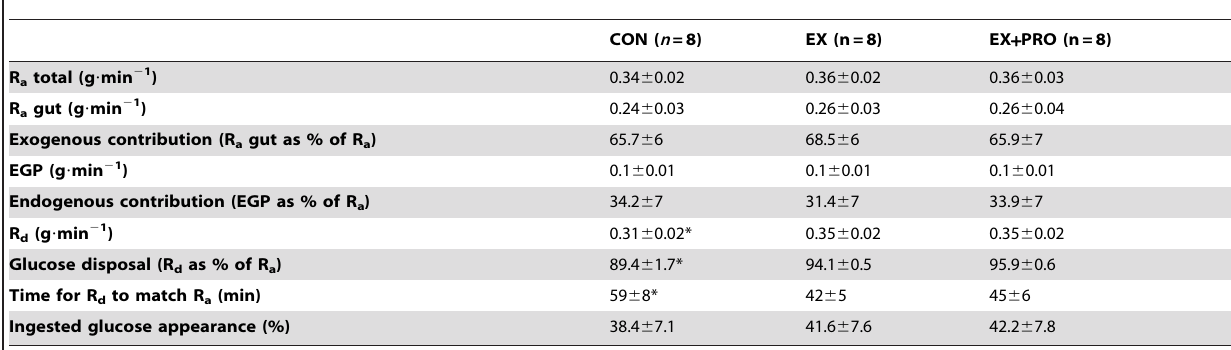
Data presented for [6, 6- 2 H 2 ] glucose rate of appearance (R a total) and disappearance (R d ) and R d expressed as % of R a . Contribution of exogenous [U- 13 C] glucose from the gut (R a Gut) and endogenous glucose production (EGP) to R a total are presented. Groups as per Table 1. *indicates significantly lower than EX and EX + PRO ( P , 0.05). Values are presented as means 6 SEM over 120 min OGTT. doi:10.1371/journal.pone.0020613.t003 (Figure 6B). Compared with basal, Akt phosphorylation did not change immediately post- and 24 h post-exercise in all groups. At 26 h post-exercise, following OGTT, Akt phosphorylation in- creased by 2.2-, 2.3 and 1.9-fold for CON, EX and EX + PRO, respectively, compared with 24 h post-exercise ( P , 0.05). Akt phosphorylation at 26 h post-exercise was greater for EX and EX + PRO compared with CON ( P , 0.05). Basal p70S6K Thr389 and PRAS40 Thr246 phosphorylation (Day 1) was similar for all groups (Figure 6C and 6D, respectively). Compared with basal, p70S6K and PRAS40 phosphorylation was not different imme- diately-, 24 h- or 26 h-post exercise. There was no between-group difference in p70S6K or PRAS40 phosphorylation immediately-, 24 h- or 26 h-post exercise. All representative western blot images are presented in Figure 7.